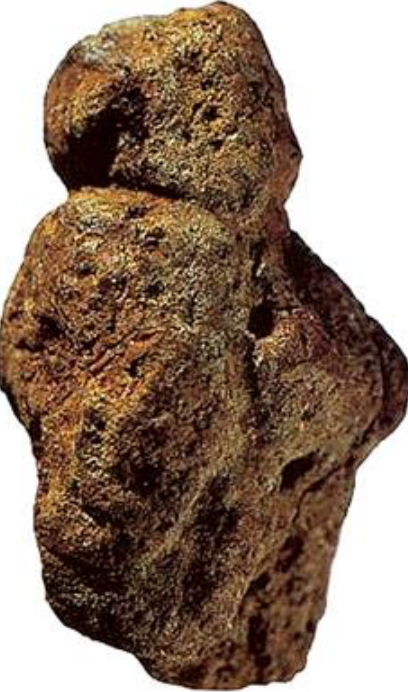
Figure 24. Scoria pebble from the Late Acheulian deposit of Berekhat Ram, Israel, modified by several anthropogenic grooves and abraded